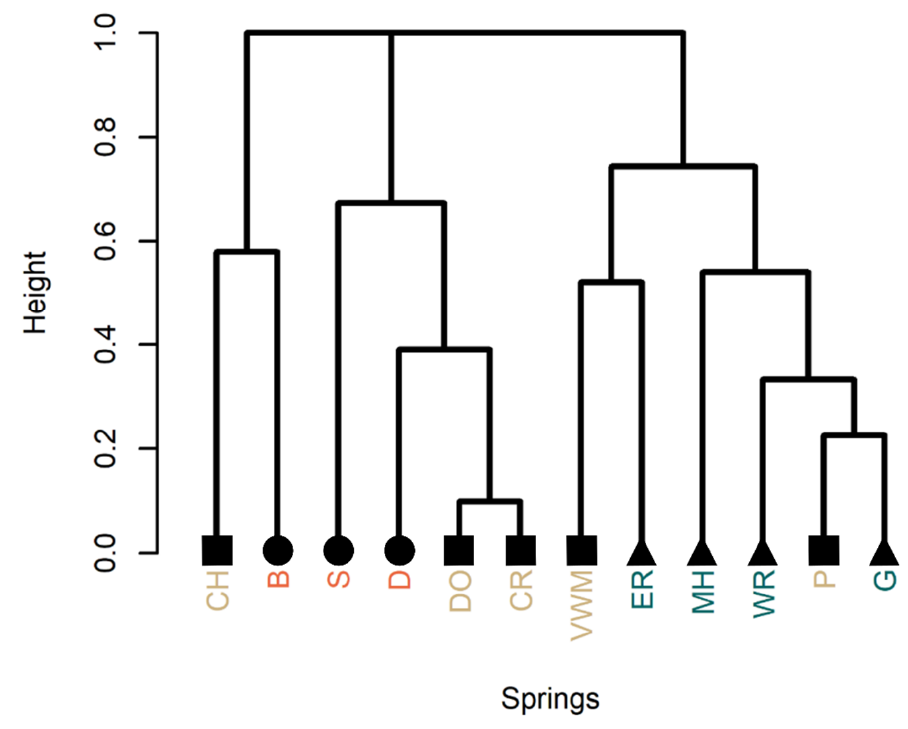
Figure 2. Bray–Curtis dissimilarity dendrogram of the resident odonate assemblage at 12 investigated streams. Shading and shapes indicate the three classes of riparian impact: Orange and circles = highly impacted, Tan and squares = moderately impacted, Green and triangles = minimally impacted. Site abbreviations are defined in Table 1. The ‘height’ scale on the vertical axis of cluster dendrograms gives Bray–Curtis distance measure values between clusters of